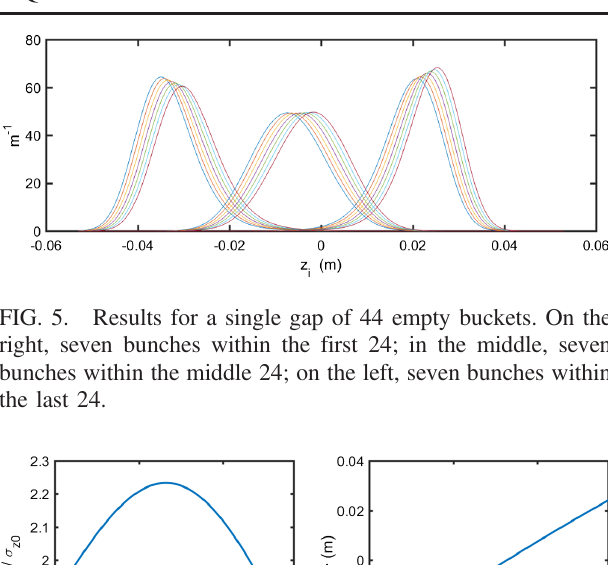
FIG. 7. Results for distributed gaps, each consisting of four empty buckets. Plots of six bunches out of a train of 26.